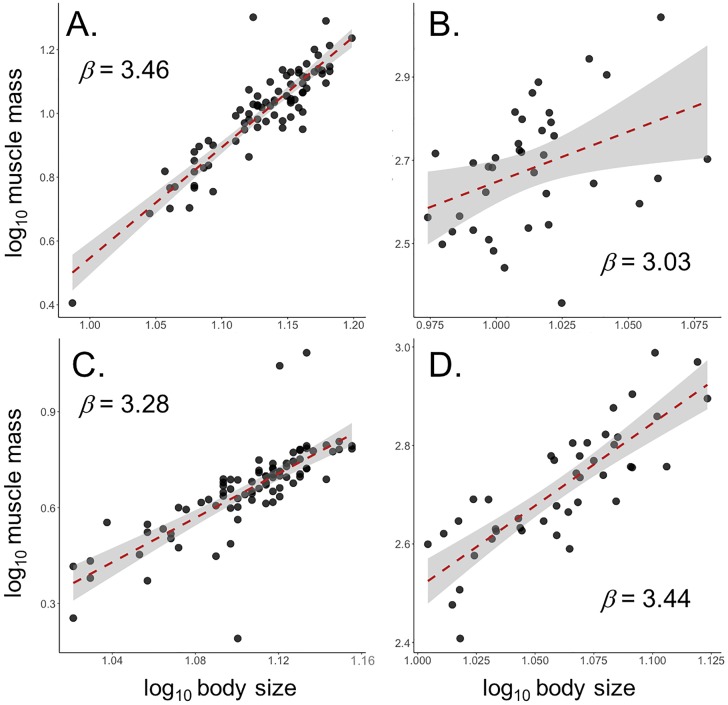
Relationship between hindlimb muscle mass and body size for A) male S. femorata, B) male N. femorata, C) female S. femorata, and D) female N. femorata.Red lines represent OLS regression. Shaded areas represent 95% confidence intervals around OLS regressions.